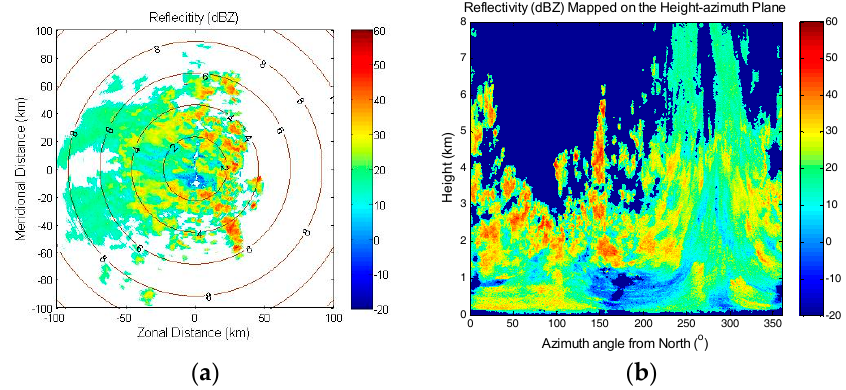
Figure 10. Radar reflectivity measured at 14:55 UTC on 14th June 2014 ( a ) PPI image ( b ) mapped on the height–azimuth plane.